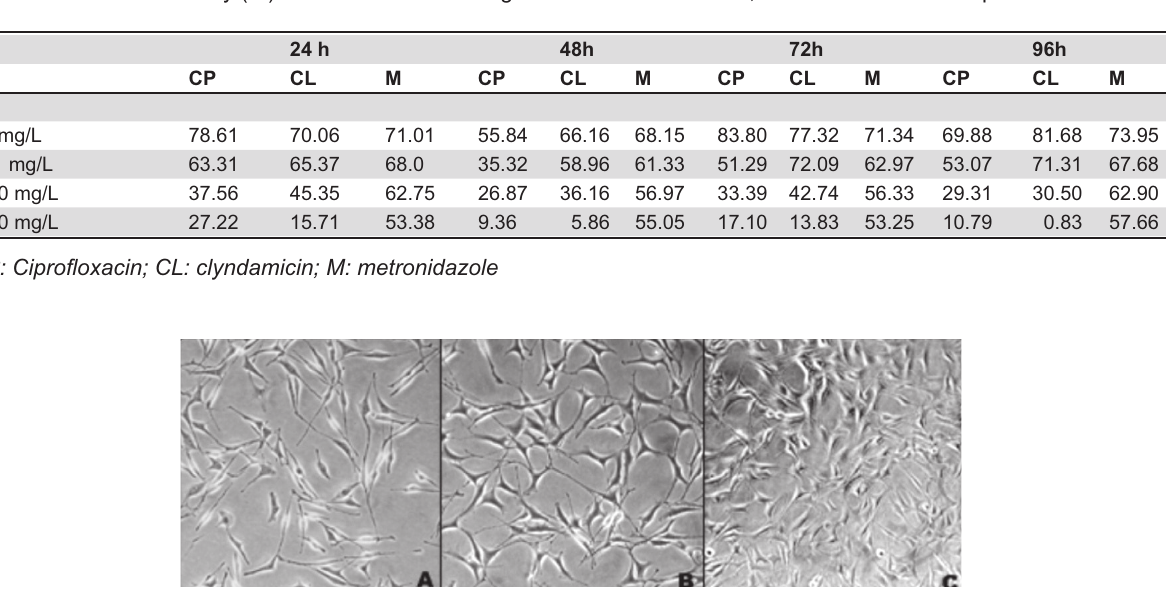
Figure 1- !"#$%"&$#' ()&")*+,% '&"-%./ 012 +#3 042 ()&")*+,% $#5&6+,$#'7 082 56**, $# ,9)5"#:96#56